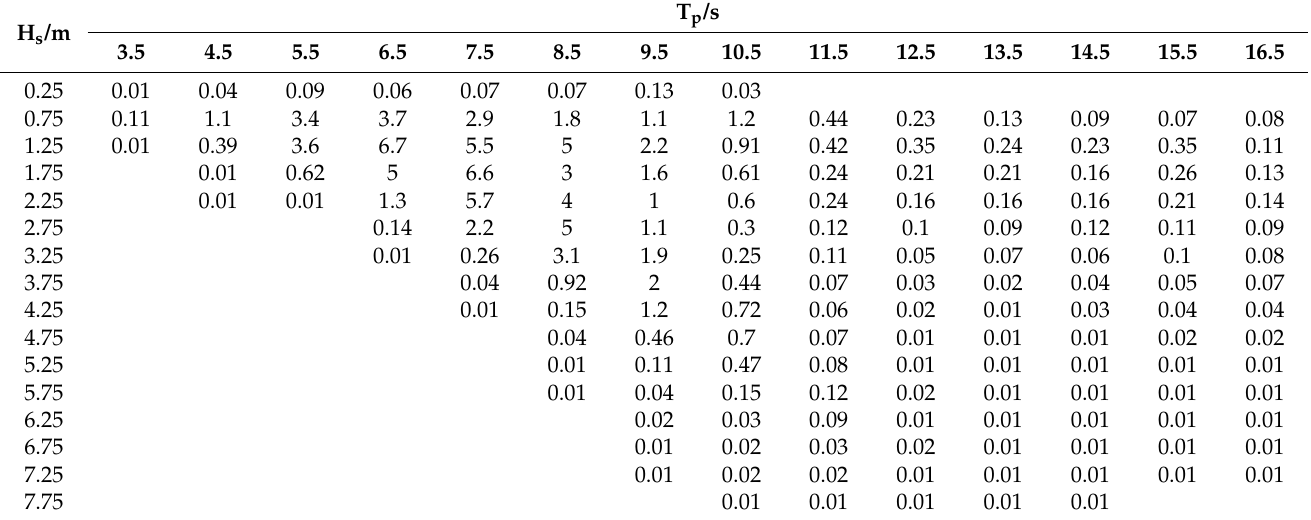
Table 3. Wave scatter diagram of the South China Sea.